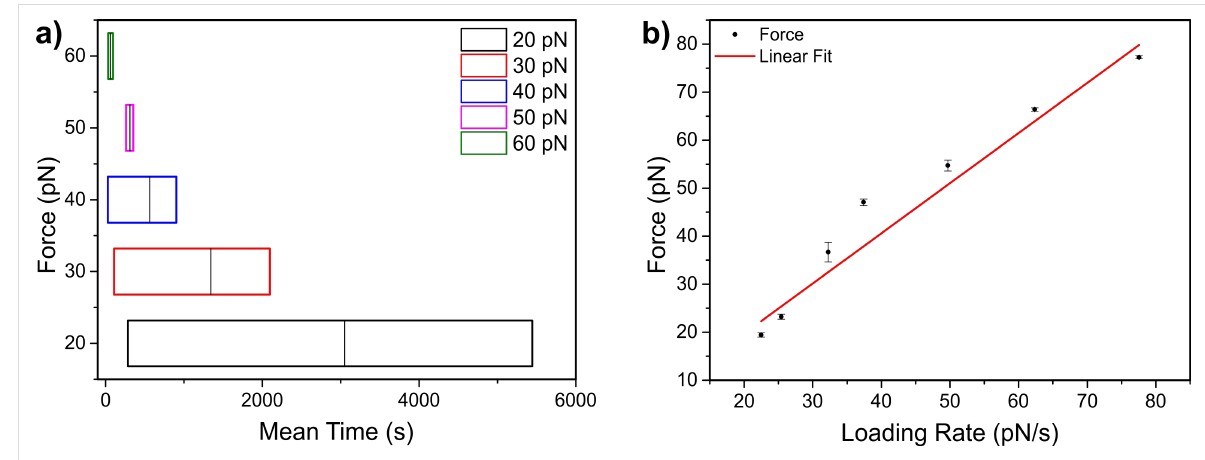
Figure 6: Studying the stability and force-induced disruption of streptavidin-labelled DNA handles in TICO buffer. a) Constant-force measurements were conducted to check the stability of the DIG::anti-DIG bond for a range of different applied tensions over time. The mean dissociation times to rupture individual PDHs are shown as vertical lines, the coloured boxes highlight the range of 25–75% of the fitted Gaussian distribution. b) Meas- ured rupture forces plotted against loading rates. Laser tweezers analyses of streptavidin-labelled DNA handles identified rupture forces ranging from 25–110 pN during a constant elongation velocity of 100 nm/s, with correspondingly varying loading rates. The loading rate (pN/s) was highest shortly before the dsDNA underwent the overstretching transition. The individually measured rupture forces at a specific loading rate were averaged. Error bars represent the SD of the individual